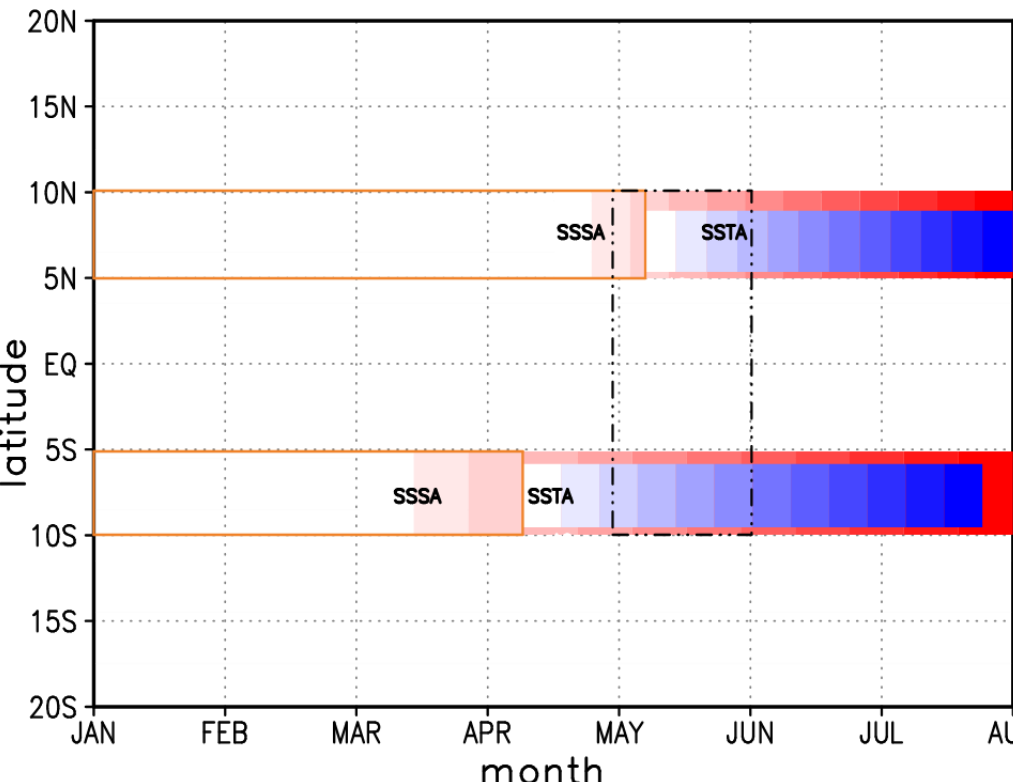
Figure 8. Diagram of the potential mechanism between SSSA and the onset of SASM along 60° E – 80° E (Gradually increasing red rectangles represent the increasing SSSA and the blue ones represent the decreasing SSTA; In addition, the orange hollow rectangles represent the increasing SSTA and the black dot-dashed rectangle indicates the period with large SSTA gradient).